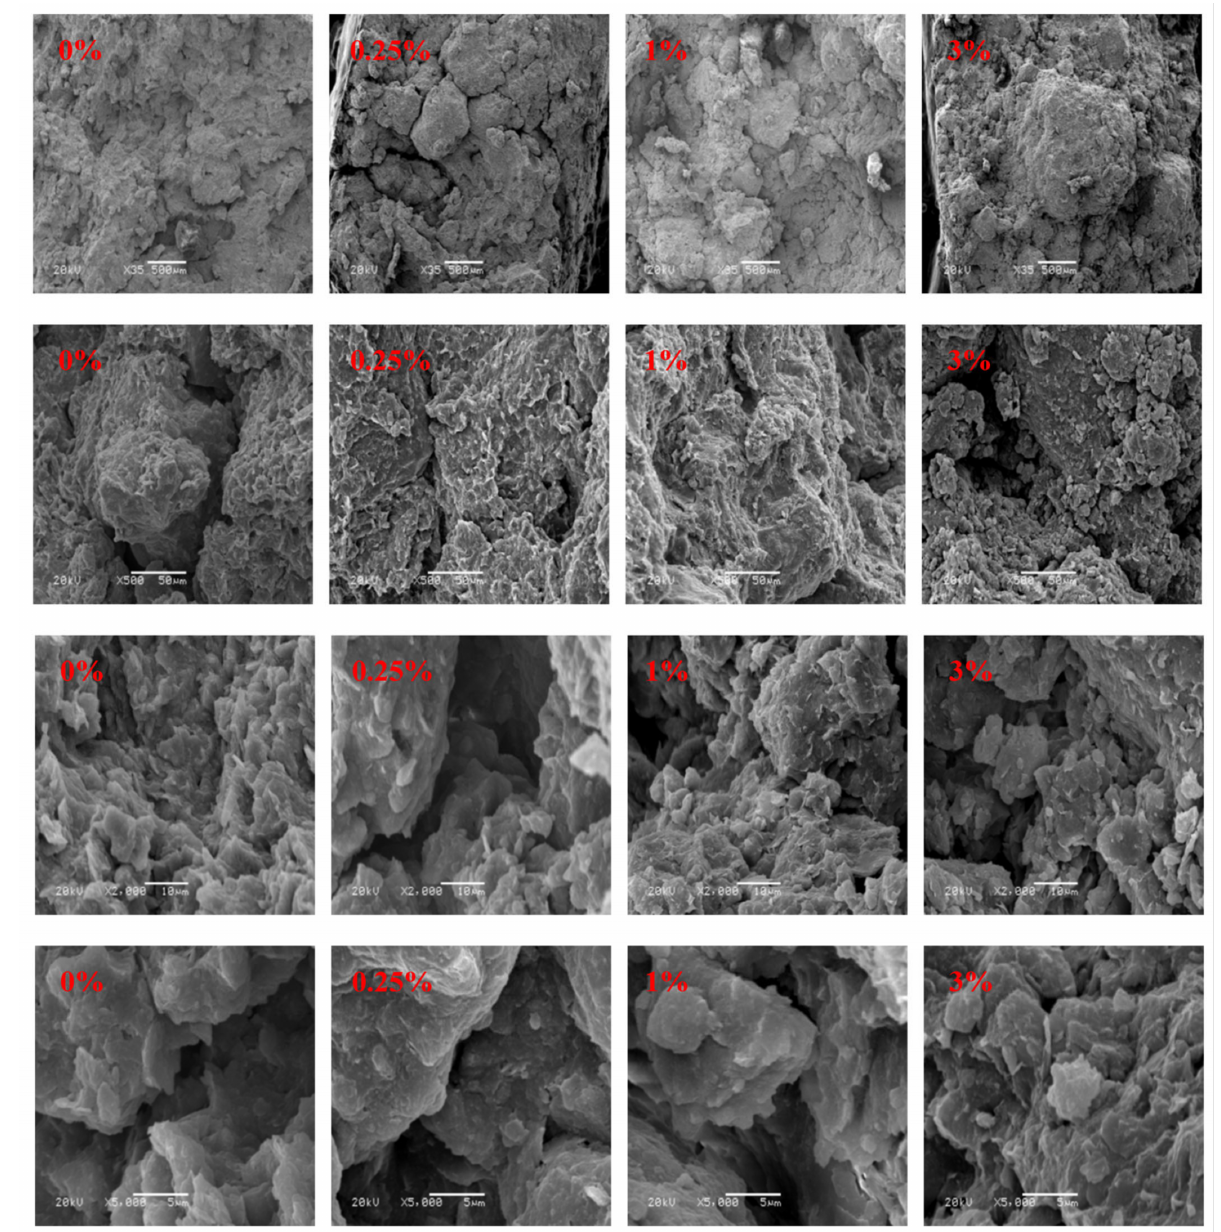
Figure 7. SEM images of soil samples with various NS contents (from above to below, magnification times: × 35, × 500, × 2000, ×